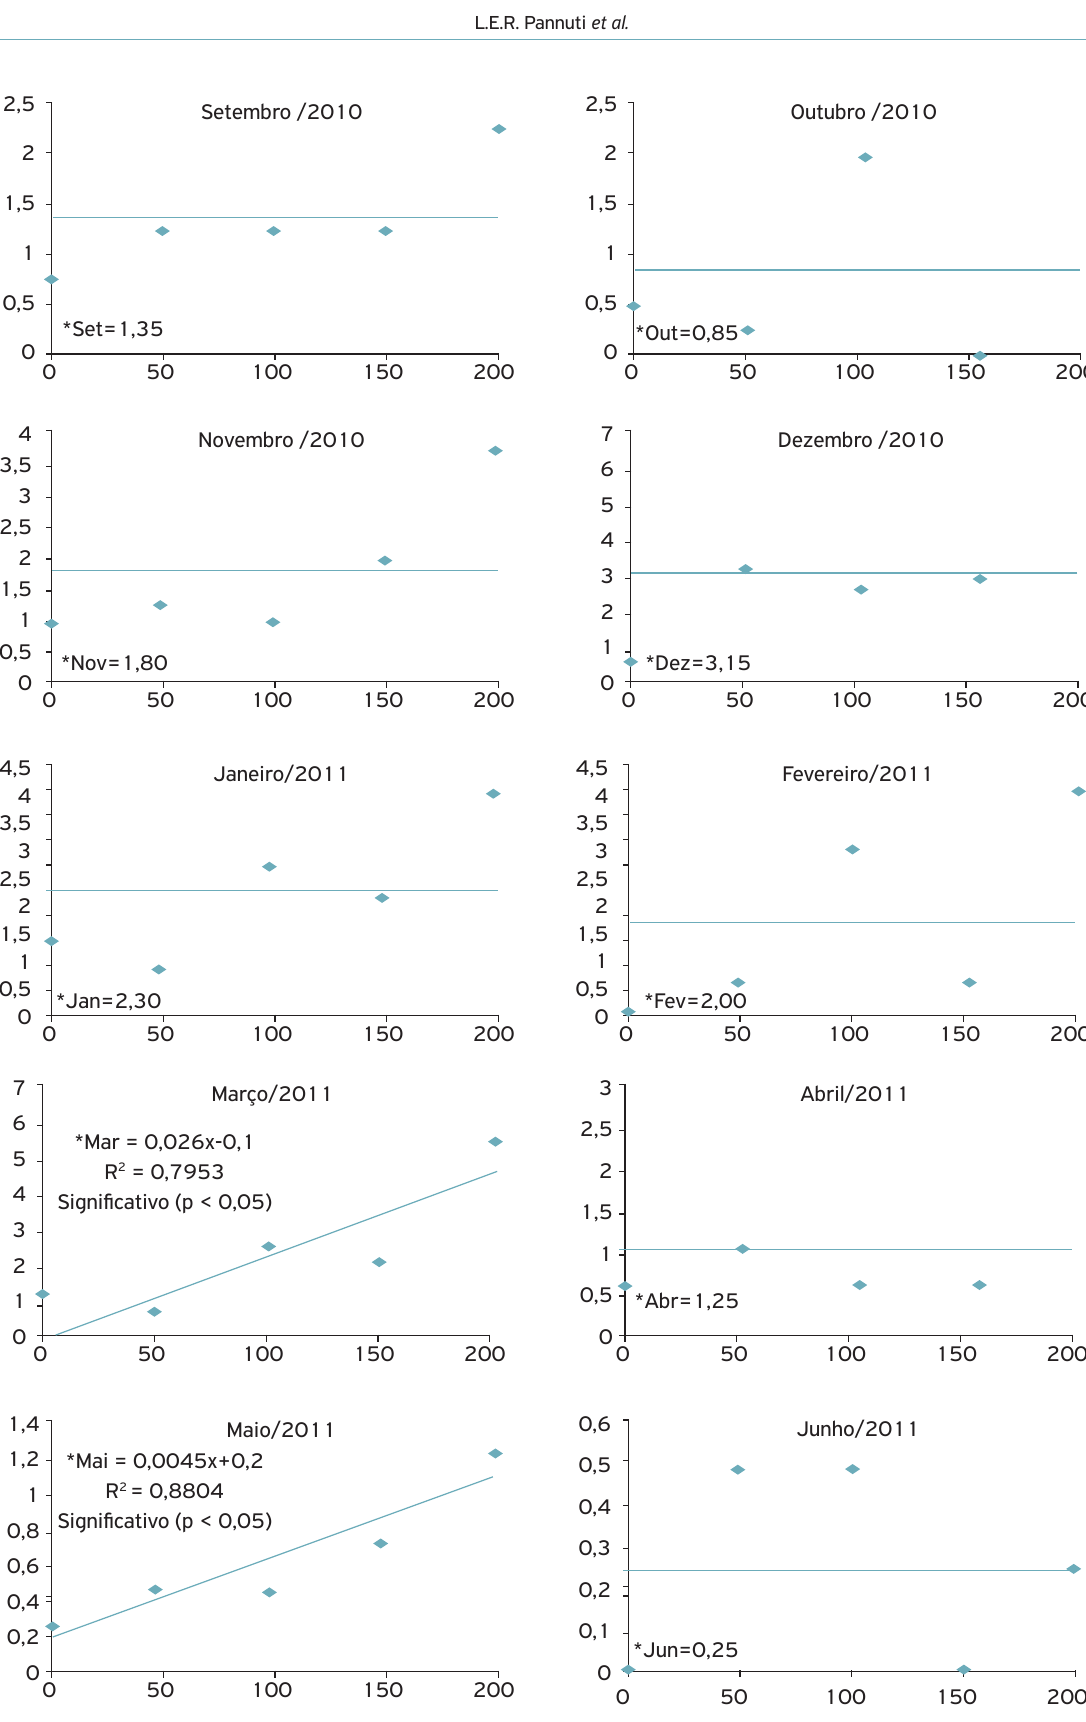
Figura 1. Número médio de ninfas de M. fimbriolata em razão da aplicação de diferentes doses de N-fertilizante, entre os meses de setembro de 2010 e junho de 2011, safra 2010/2011, em cana-de-açúcar irrigada, Jaú,